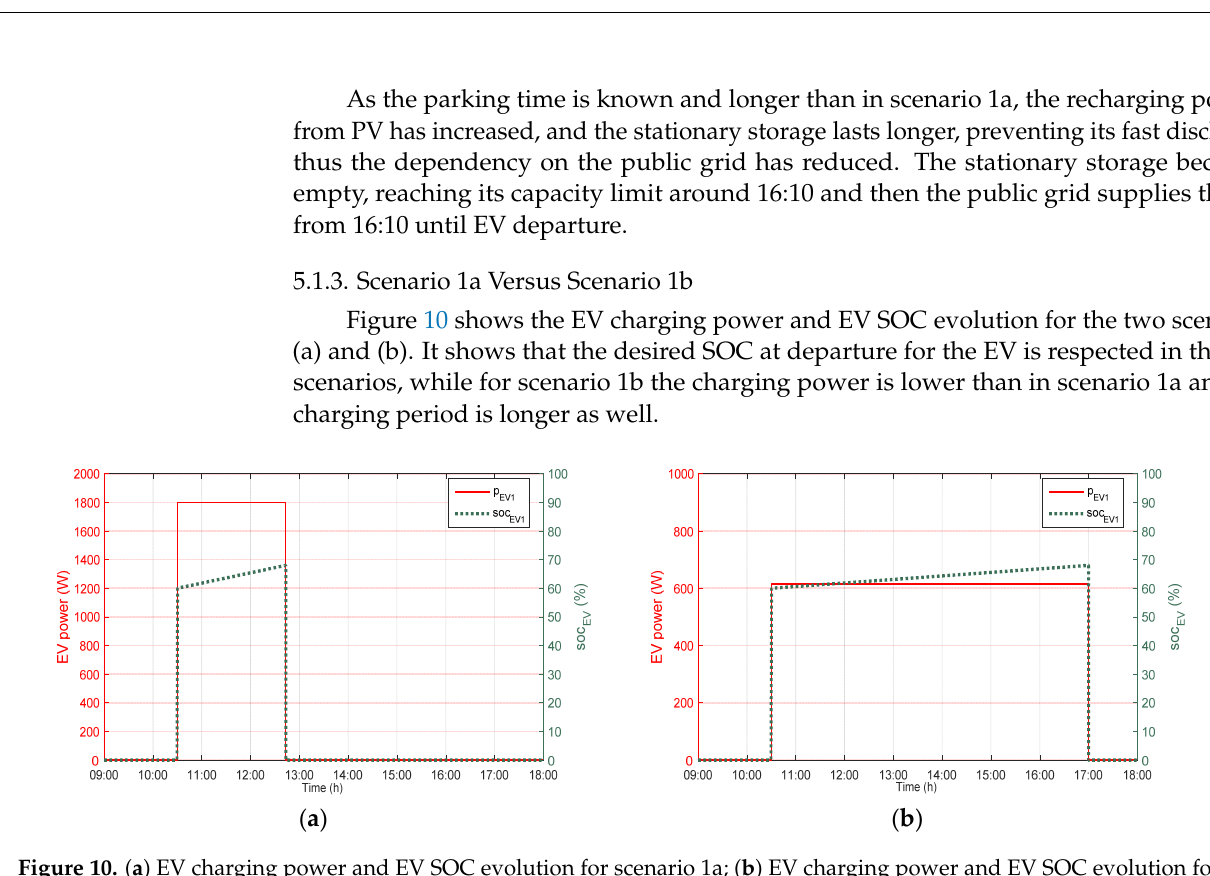
Figure 9. Scenario 1b, system power flows and stationary storage SOC evolution.